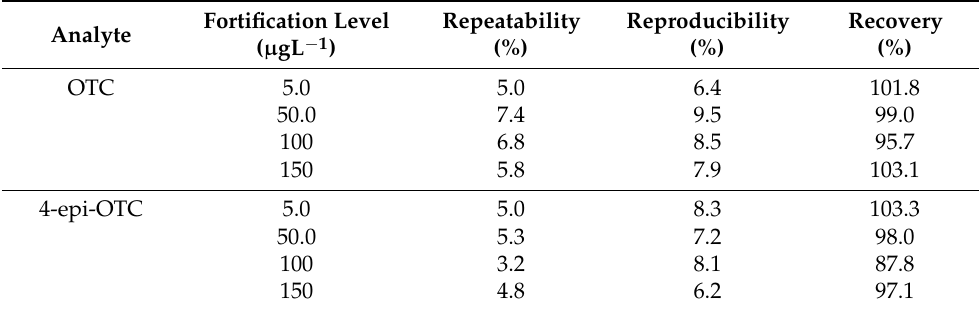
Table 1. Validation parameters (precision and recovery) of the method for the determination of OTC and 4-epi-OTC in sow milk.